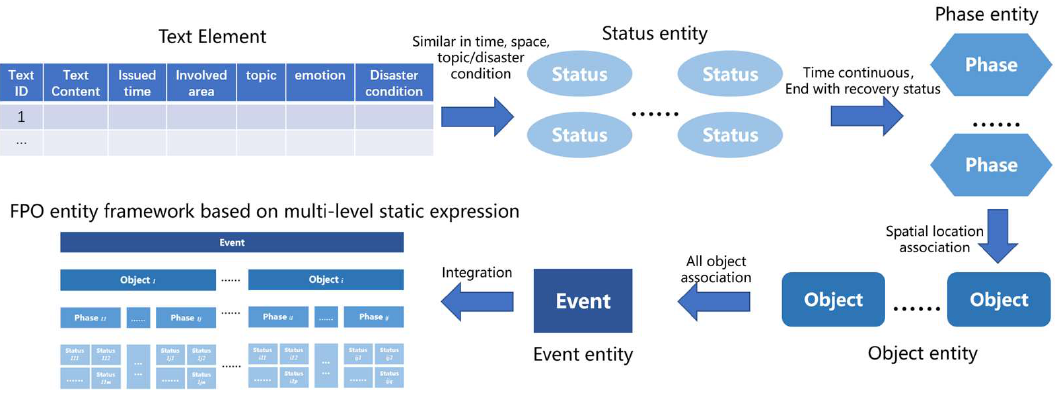
Figure 8. Schematic diagram of the FPO entity construction process based on static expression. Step 1 Construct status entity: